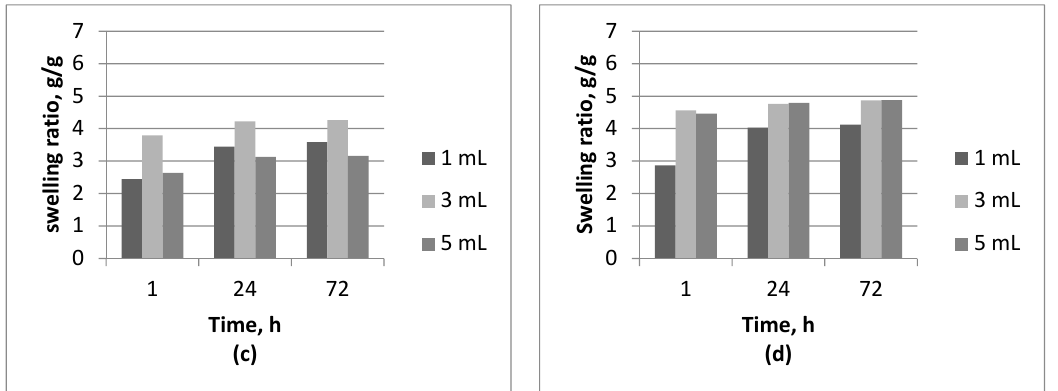
Figure 2. Comparison of swelling ability of chitosan hydrogels in: ( a ) SBF; ( b ) artificial saliva; ( c ) Ringer’s liquid; and ( d ) distilled water.By comparison, the study effects of the Beetosan ® materials with those obtained on the basis of commercial chitosan some similarities regarding the time and the liquid medium used are observed, however some differences between them also are visible (Figure 2). The addition of 5 mL of nanosilver to the hydrogels based on commercial chitosan results, in most cases, in an improvement of the sorption capacity. The only exception is observed in the case of Ringer’s liquid (Figure 2c). That can be due to an unfavorable arrangement of the hydrogel sample during